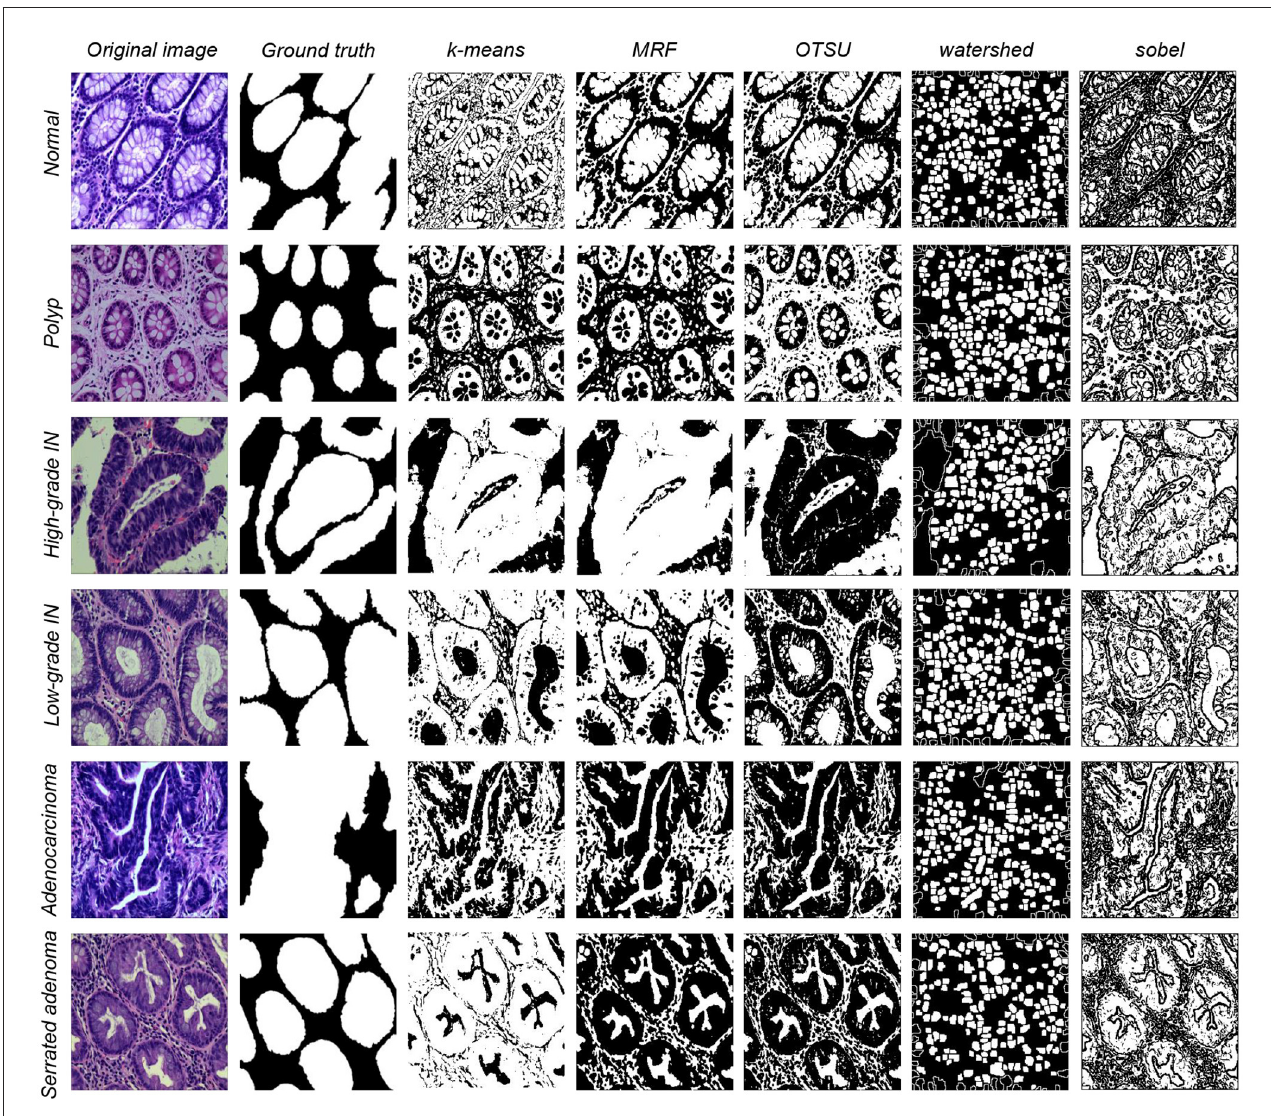
FIGURE2 Five types of data segmentation results obtained by different classical machine learning